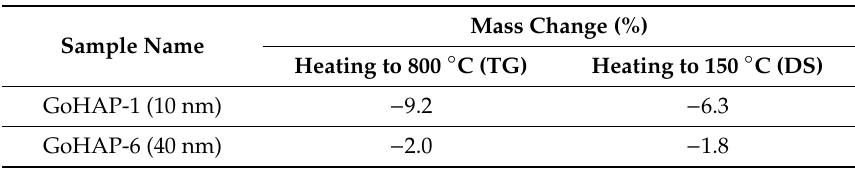
Table 6. Mass changes in GoHAP ™ during thermogravimetric analysis (TG) and in the desorption station